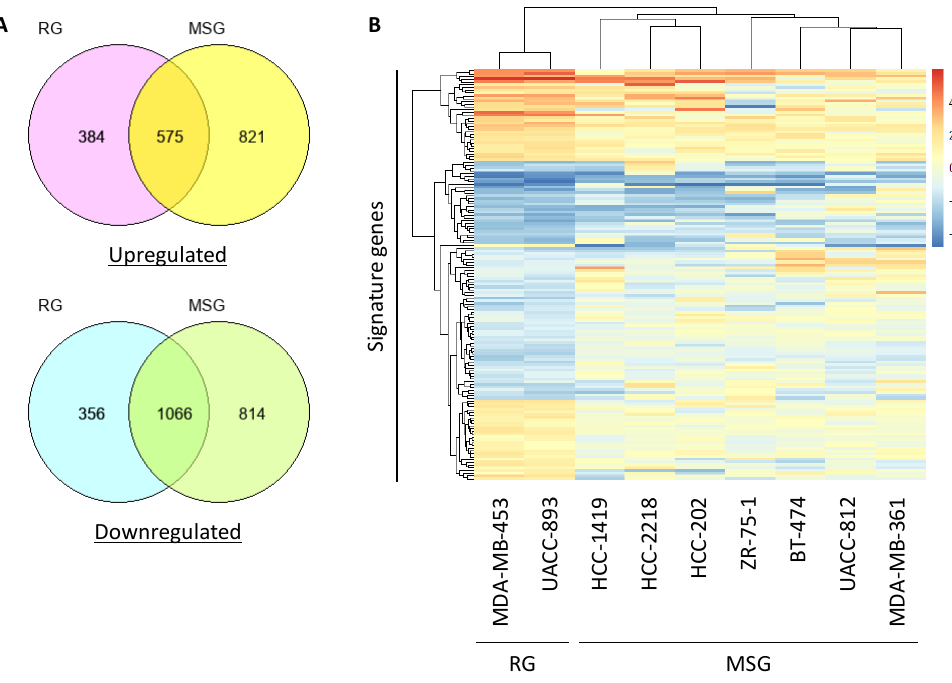
Figure 4. Signature genes associated with brain colonization in the RG. ( A ) The number of upregulated and downregulated genes in the RG or MSG is described in Venn diagrams. ( B ) Genes that were differentially expressed between the RG and MSG according to microarray data were analyzed by hierarchical clustering and are shown in a heatmap.